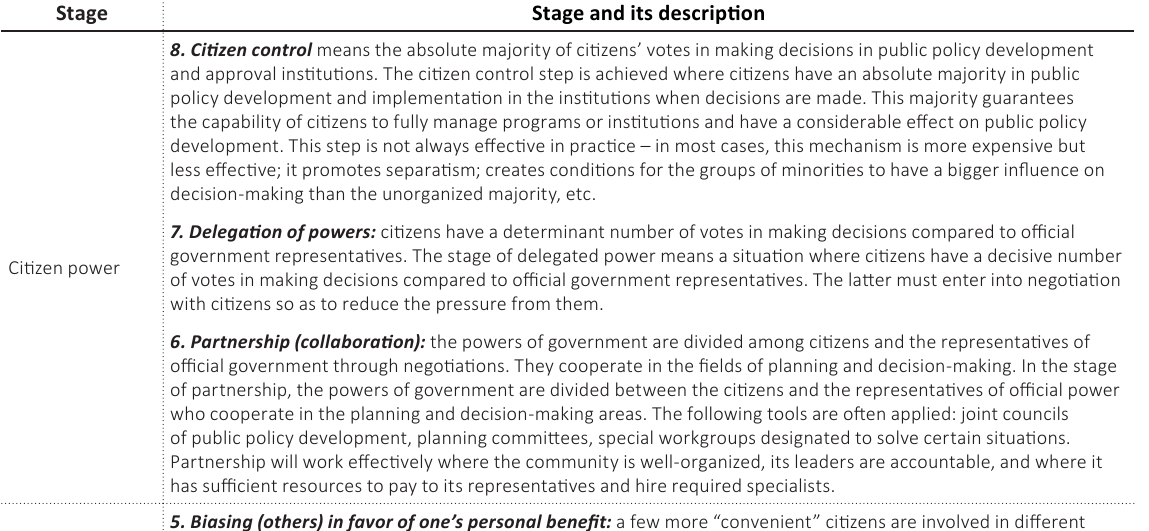
Source: Based on Arnstein